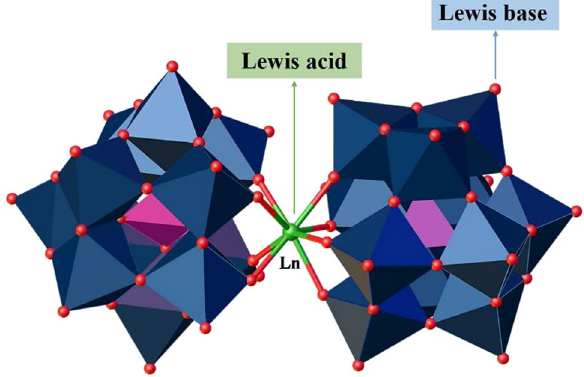
Figure 2. The structure of Ln-B 2 W 22 nanocatalyst (Color code: W, dark blue; Ln, grey; O, red; B, purple). Reproduced from ref 40 with